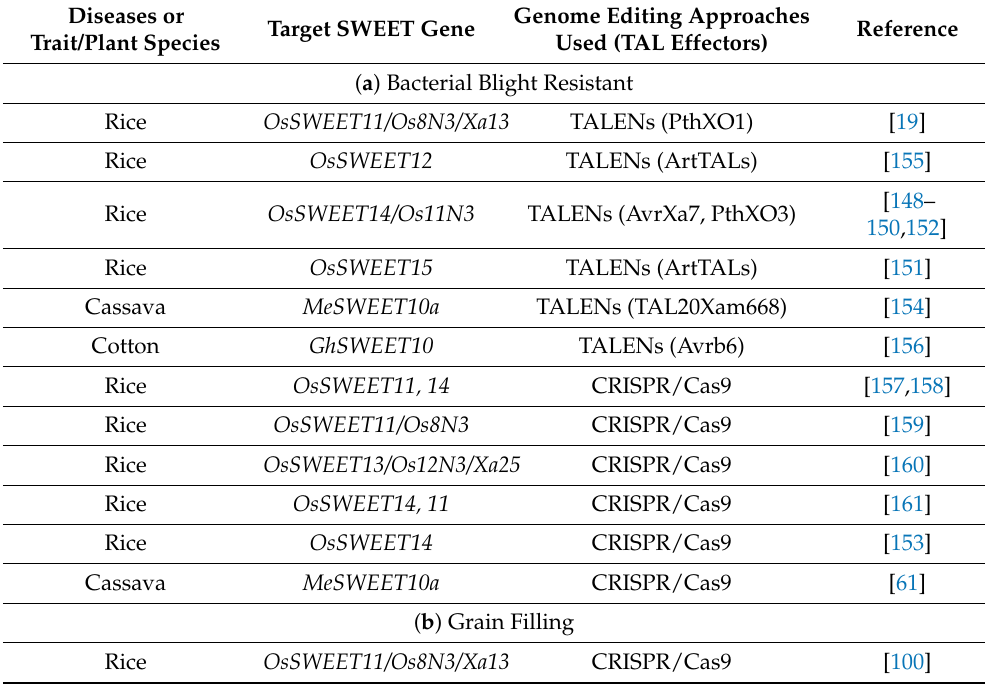
Table 2. Genome editing approaches utilized to target SWEET genes in